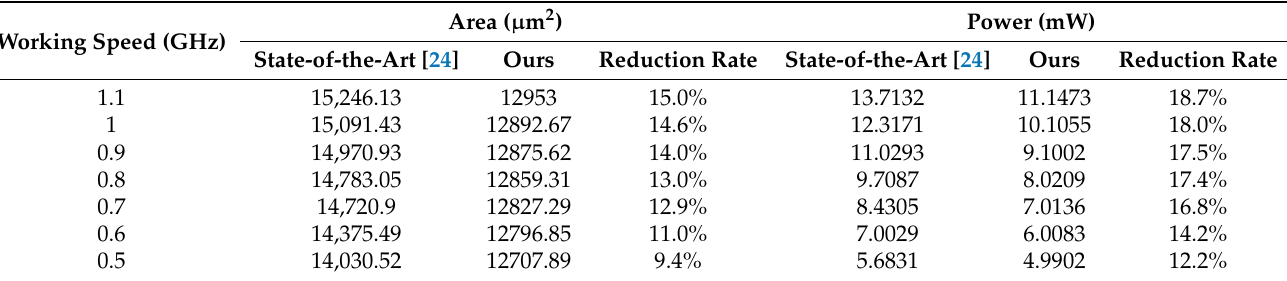
Table 4. Comparisons on different 3 × 3 CA-W